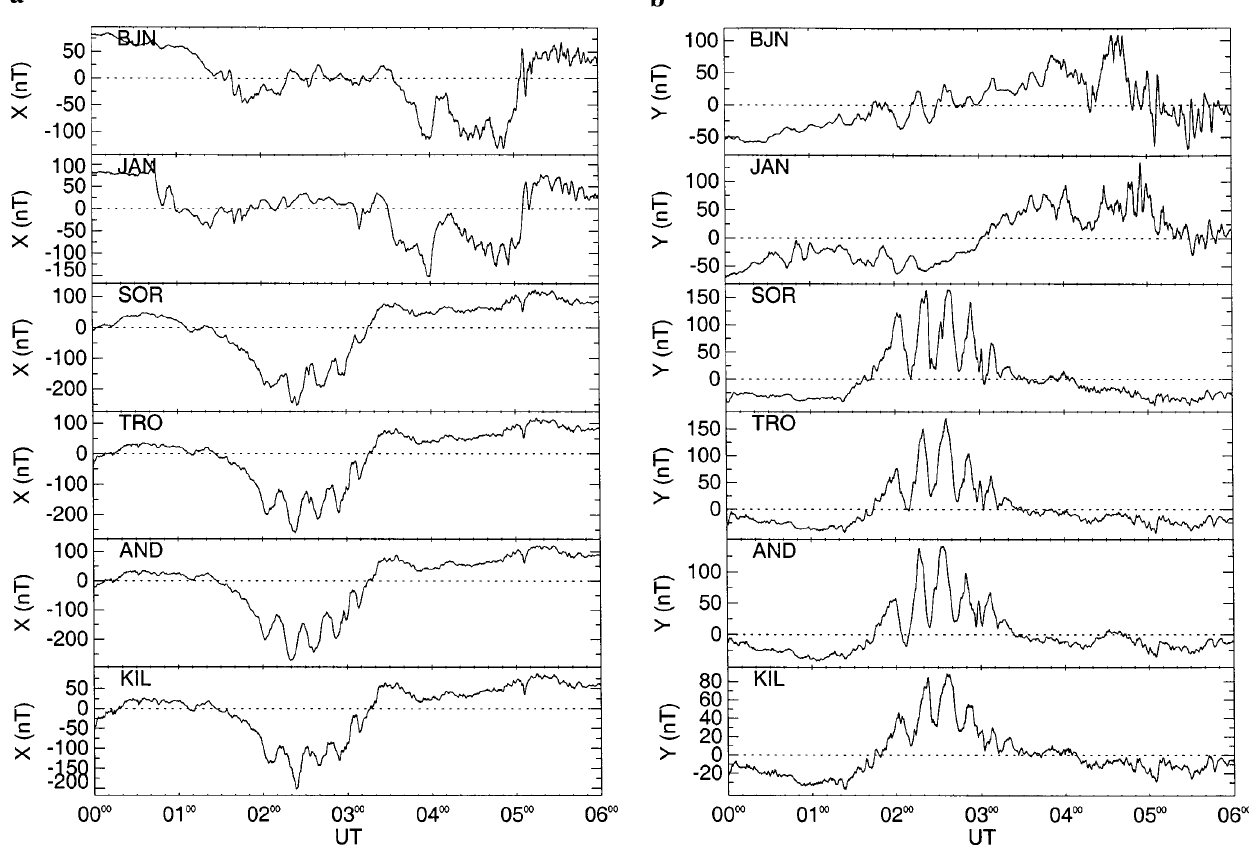
Fig. 2a, b. Ground magnetograms from the IMAGE array and Tromsø Auroral Observatory magnetometer located at Jan Mayen for the period 00:00–06:00 UT on 11 May, 1998. a X components, b Y